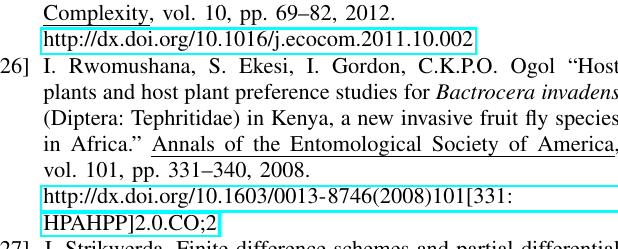
C Dufourd et al., Parameter Identification in Population Models for Insects Using Trap Data mating insect population density from trap counts.”